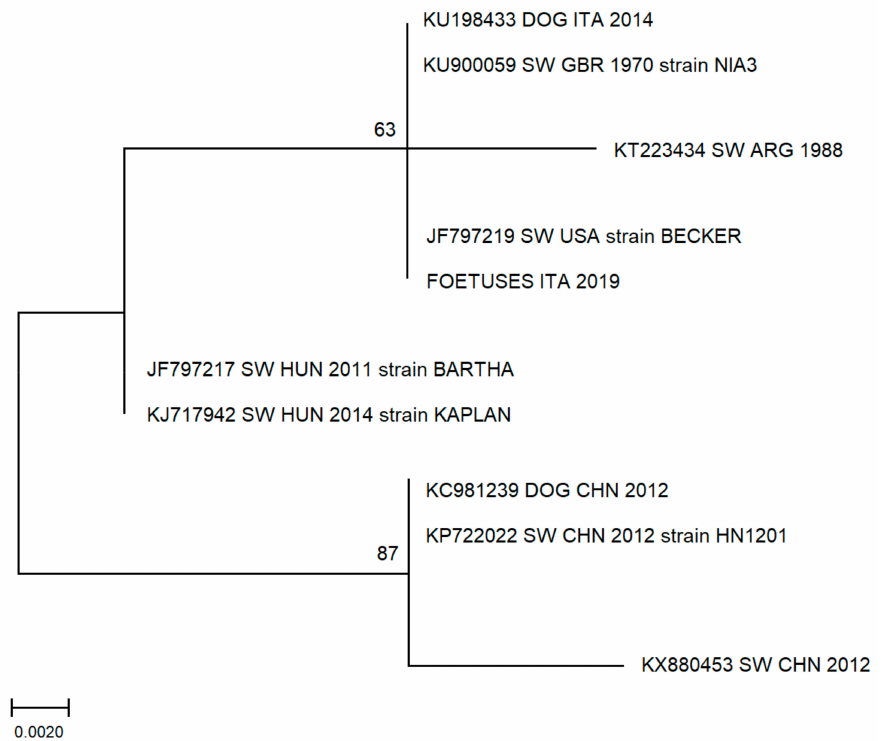
Figure 1. Molecular phylogenetic analysis by maximum likelihood method. The evolutionary history was inferred by using the maximum likelihood method based on the Tamura–Nei model. The percentage of replicate trees in which the associated taxa clustered together in the bootstrap test (500 replicates) is shown next to the branches. The analysis involved 10 nucleotide sequences. There was a total of 148 positions in the final dataset. Evolutionary analyses were conducted in MEGA7. (ITA: Italy; GBR: Great Britain; ARG: Argentina; USA: United States of America HUN: Hungary; CHN: China; SW: